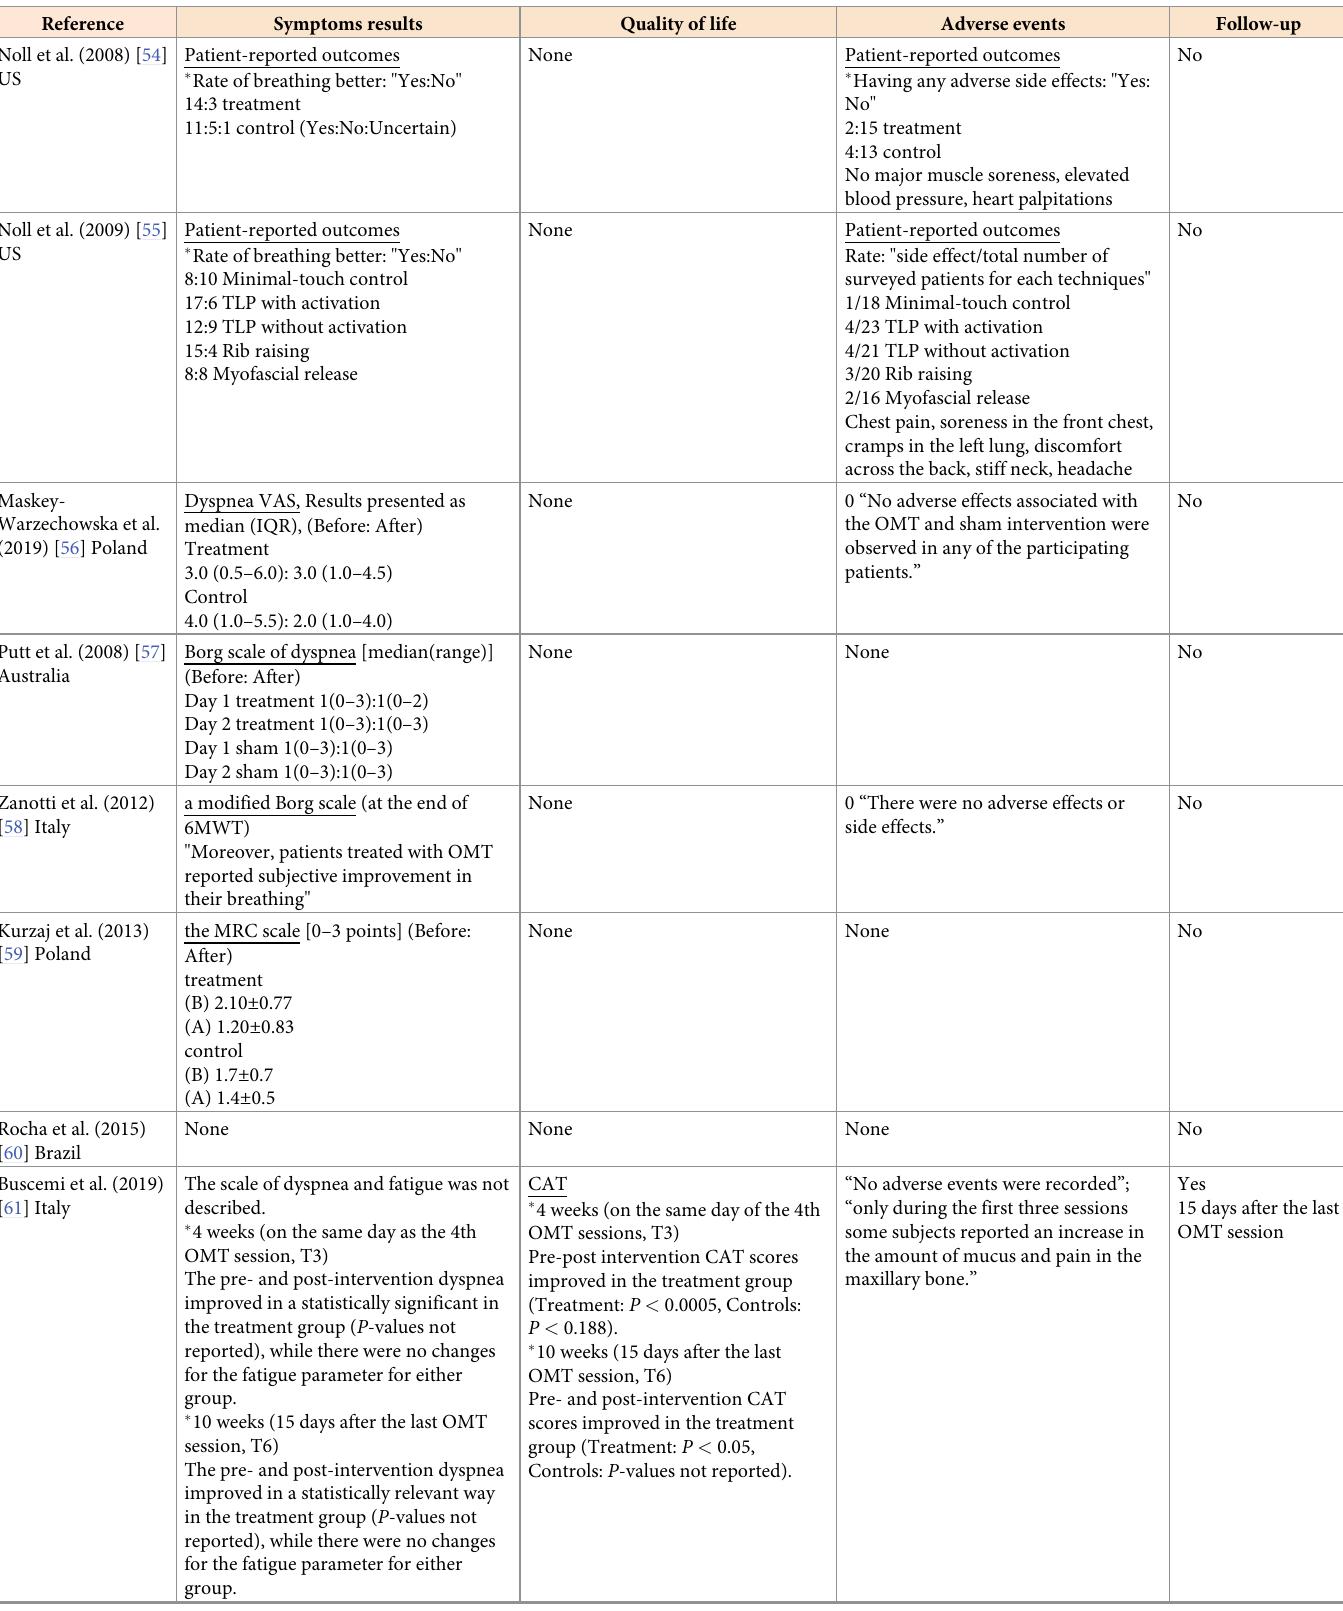
Table 3. Summary of secondary